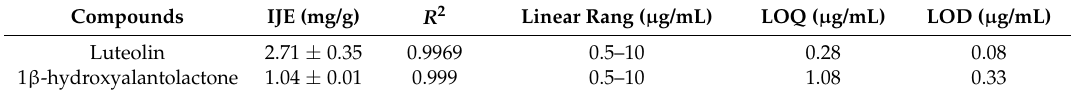
Table 4. Quantification of luteolin and 1-hydroxyalantolactone in IJE.